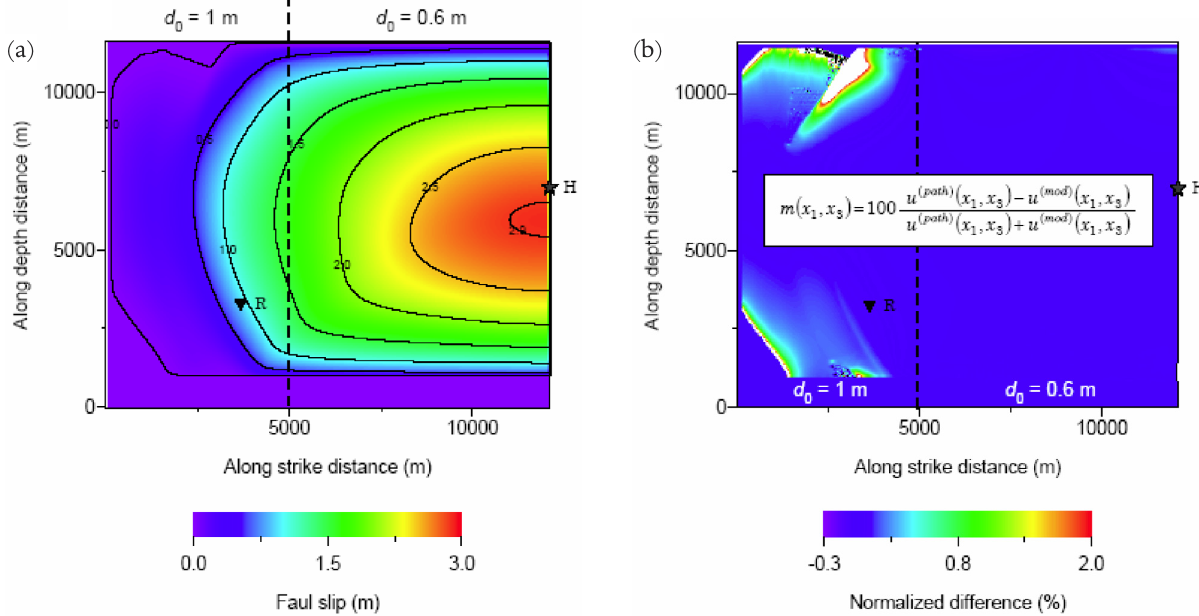
= 1 m at distances from the hypocenter lager than 5 km. The other pa- Figure 6. The same as in Figure 2, but now for a model having d 0 rameters are the same as in Model B, with the exception of an unbreakable barrier extending 1 km below the free surface. In panel (b) the scale is clipped at 2% just to emphasize the (positive) differences near the supershear front.